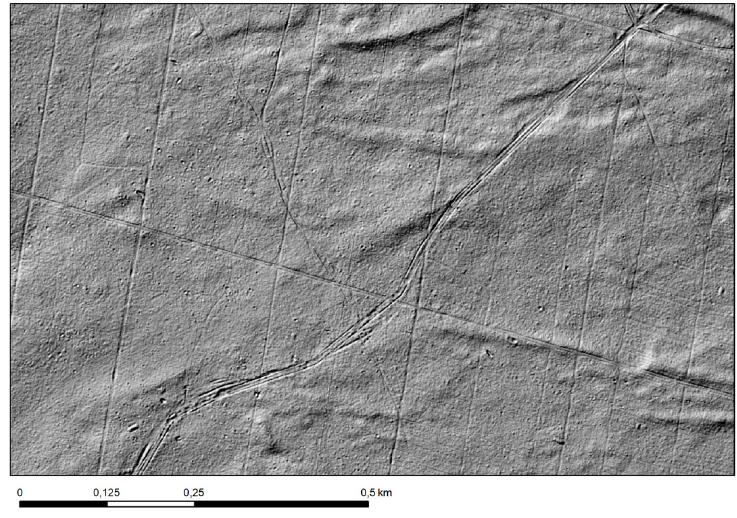
Fig. 8. Preserved terrain form of the no longer existing 18th-century road between Dąbrówka and Nowy Dwór visible on DTM [hillshading] (currently, forest area) (author’s own work)